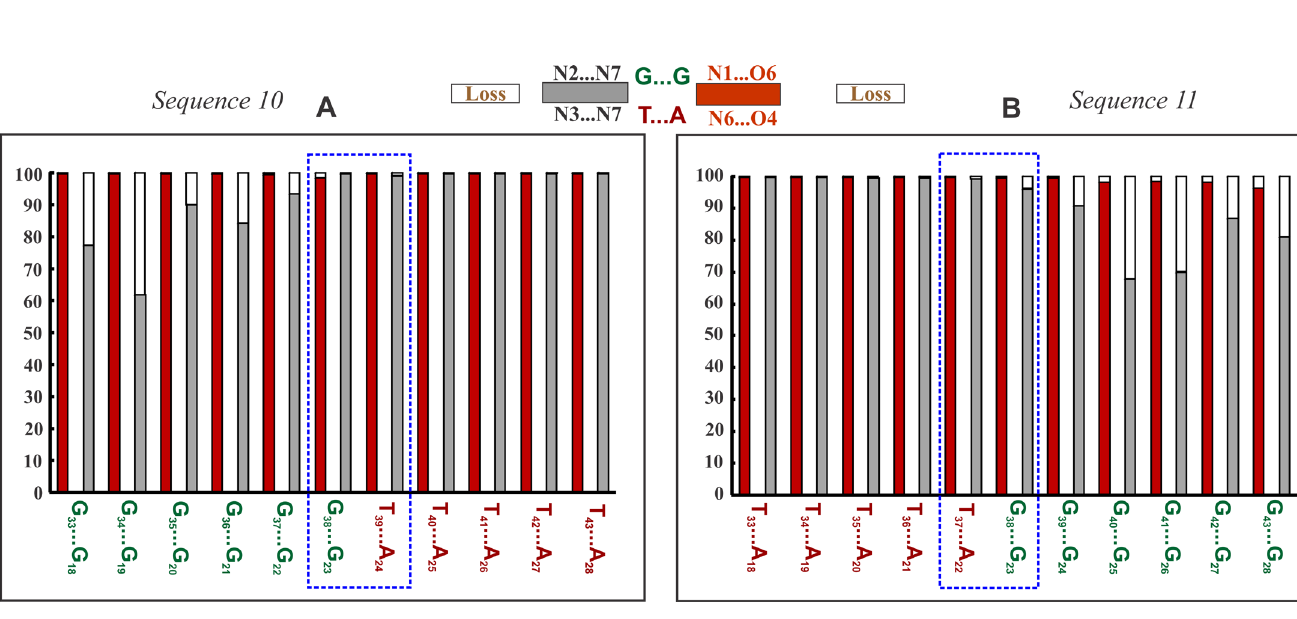
Fig 4. Destabilization of canonical Hoogsteen hydrogen bond in the G * GC and T * AT interruptions. Frequency of incidence (red & gray filled part) and loss (void part) of Hoogsteen hydrogen bonds in the G * GC interruption of the T * AT triplex (A) (Sequence 4) and in the T * AT interruption of the G * GC triplex (B) (Sequence 8). Loss of the canonical Hoogsteen hydrogen bond (void part) in the interrupting G * GC (N1 ... O6) and T * AT (N3 ... N7) triplets are conspicuous (blue box).